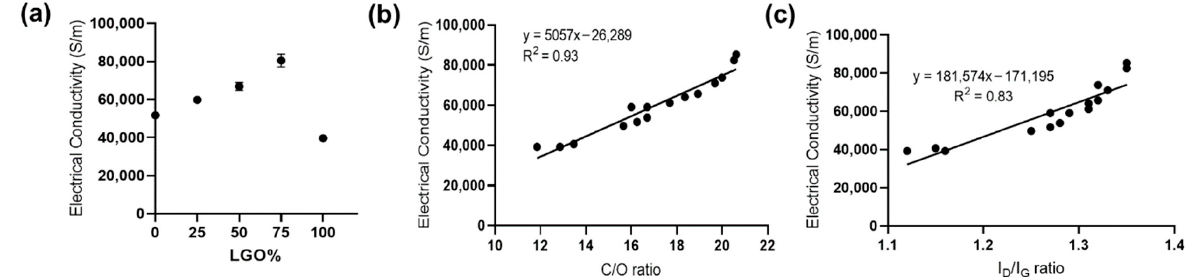
Figure 6. Electrical conductivity of rGO films. ( a ) LGO content dependence of the electrical conductivity of rGO films. All rGO films ware prepared use HI acid as reductant. The error bars represent SEM with n = 3. ( b ) Correlation between electrical conductivity and C/O ratio. The solid line represents a linear regression fit. ( c ) Correlation between electrical conductivity and Raman I D /I G ratio. The solid line represents a linear regression fit.